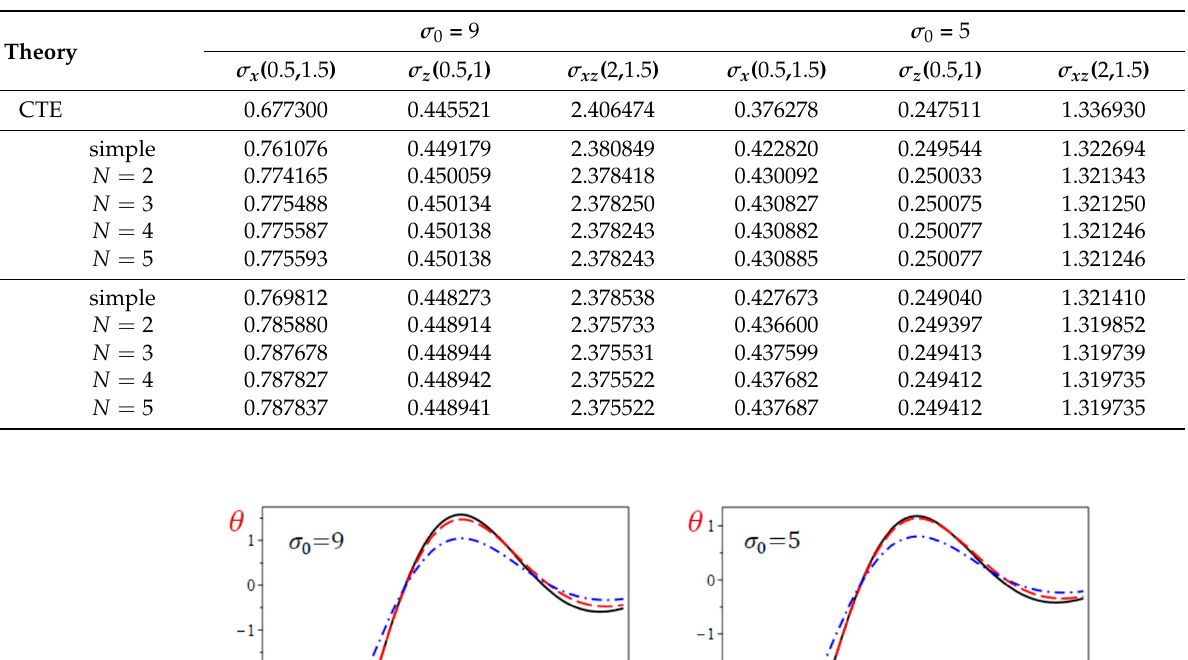
Table 4. Effect of initial stress σ 0 on the stresses of the rotating half-space without initial pressure